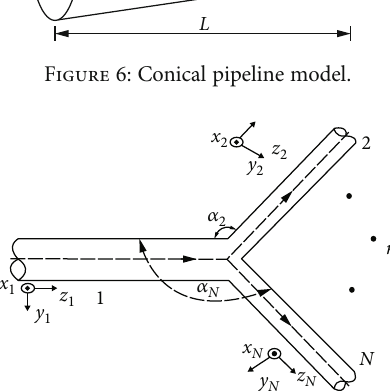
Figure 7: Multisection branch pipeline